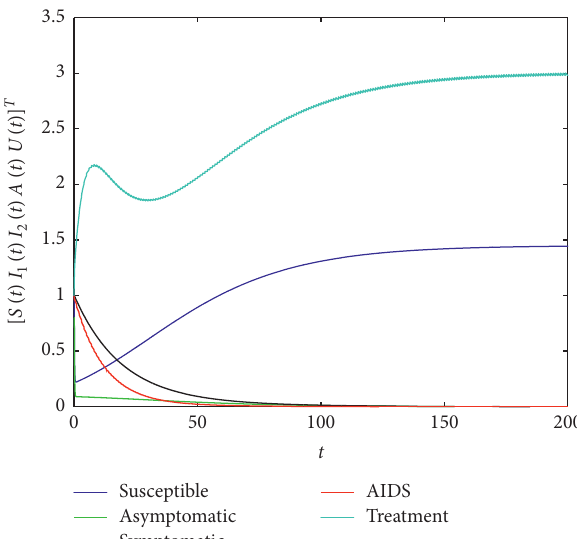
Figure 3: The solutions of system (22) with the fractional order α � 0 .